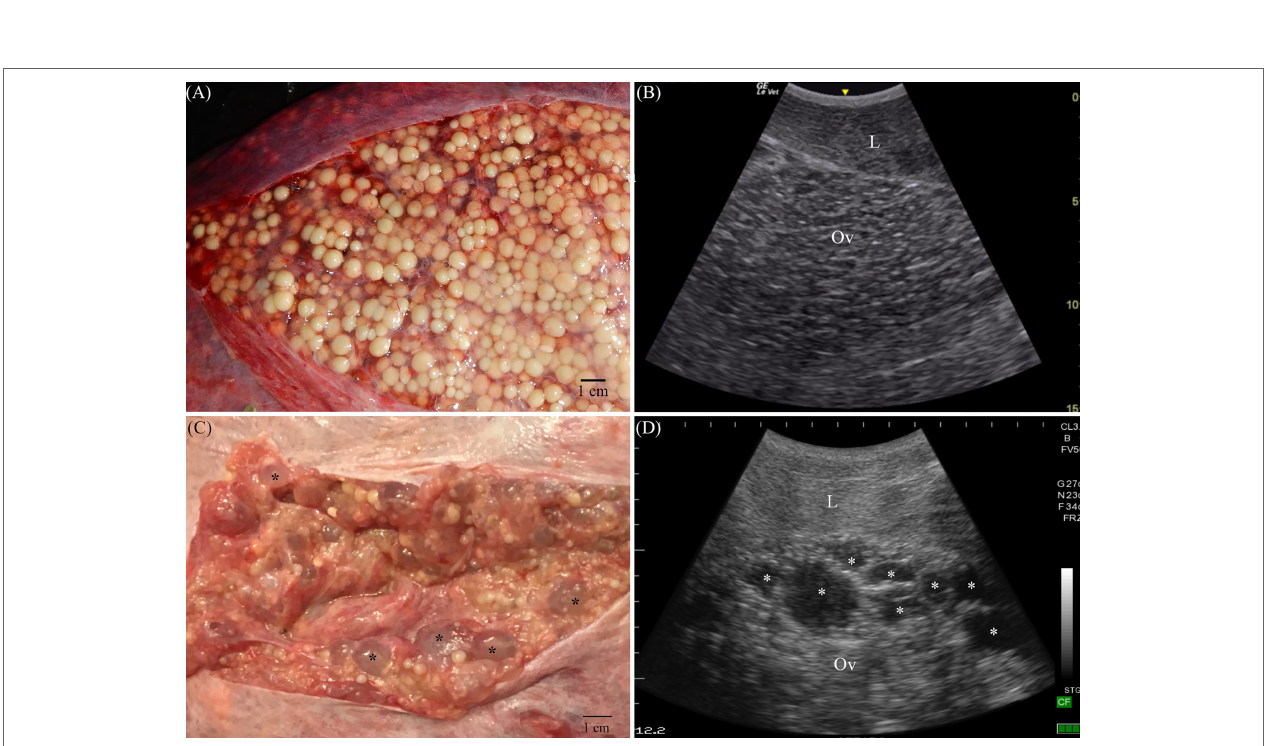
FIGURE 2 | Sand tiger shark females develop large vitellogenic ovaries with thousands of follicles (A) during spring of their active reproductive year. Using ultrasonography (B) , with the transducer in transverse orientation on midline just caudal to the pectoral girdle, the ovary (Ov) is juxtaposed to liver (L) and extends caudal to the anterior oviduct. A cystic ovary (C) is composed of yellow yolky vitellogenic follicles and fluid filled cysts (*) that appear anechoic in sonograms (D) . Scale (cm) is at the right (B) or top and left (D) edge of